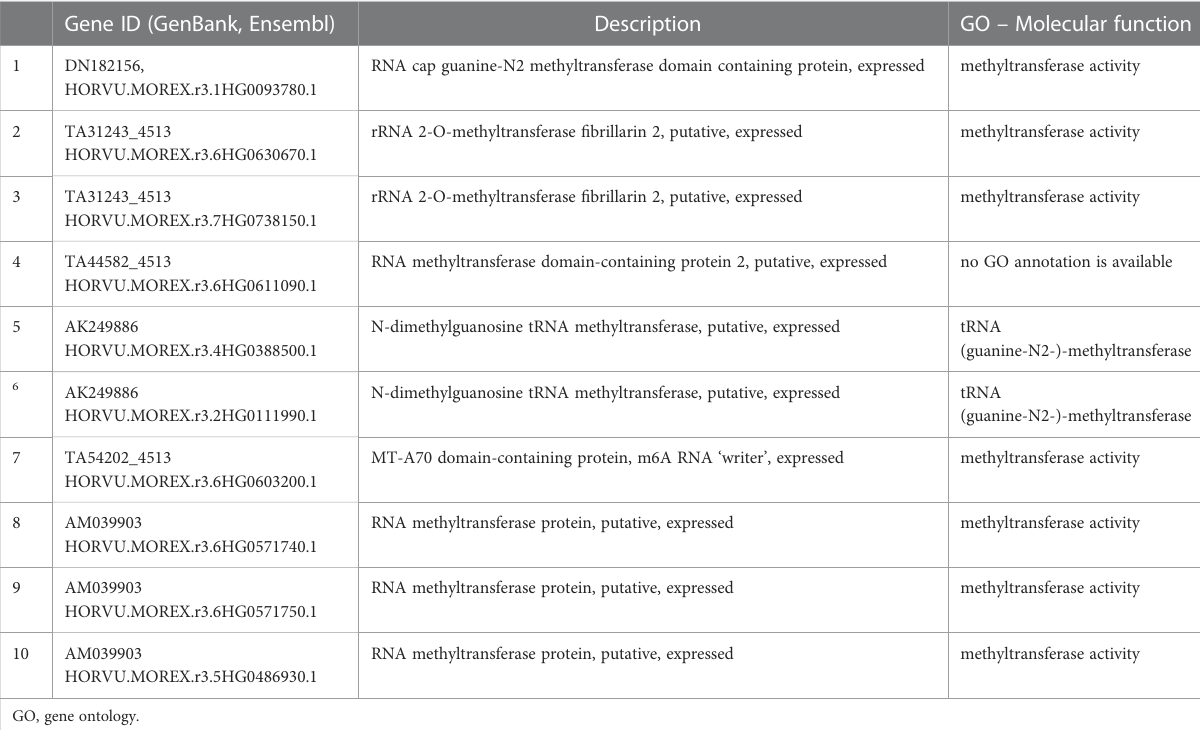
RNA methyltransferases of different RNA types, namely, TABLE 1 RNA methyltransferases ( ‘ writers ’ ) genes shown to be selectively upregulated in response to dark-induced leaf senescence (DILS) in a microarray gene expression experiment (Sobieszczuk-Nowicka et al., 2018). Gene ID (GenBank,